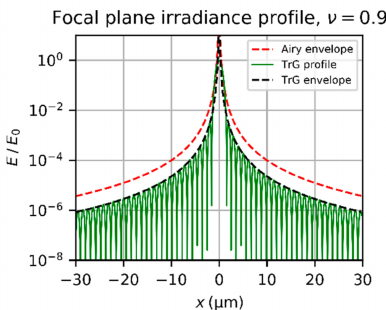
Figure 4. Irradiance profile of the di ff raction pattern of a truncated Gaussian beam (TrG) and its envelope according to Equation (14) and Equation (16), respectively. Calculation parameters: λ = 532 nm, f = 50 mm, F = 2.0, ν = 0.9. Additionally, the envelope of the Airy di ff raction pattern is plotted according to Equation (12) for the same incident power P in . The curves are normalized using the peak irradiance E 0 of an Airy di ff raction pattern for same incident power P in .